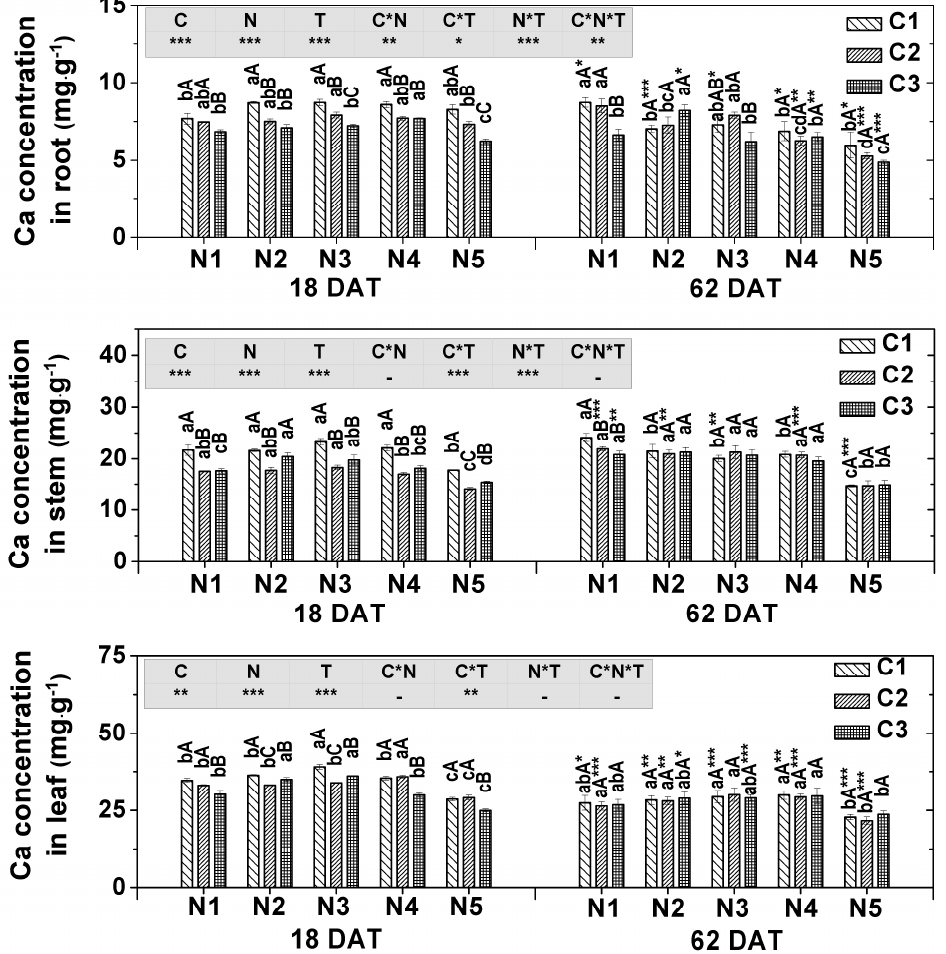
Figure 5. Calcium concentrations in different tissues of cucumber plants grown under different N and [CO 2 ] levels at two growth stages ( n = 6). Bars represent standard errors. CO 2 levels: C1, C2, and C3: 400, 625, and 1200 μ mol mol − 1 . N levels: N1, N2, N3, N4, and N5: 2, 4, 7, 14, and 21 mmol L − 1 . Means not followed by the same lower case letters are significantly different among different N levels in the same CO 2 level and growth stage, and not followed by the same upper case letters are significantly different among different CO 2 levels in the same N level and growth stage, according to Duncan’s test at p < 0.05. Means with asterisks are significantly different between two growth stages in the same CO 2 and N level (* p < 0.05; ** p < 0.01; *** p < 0.001). In the internal table, C: [CO 2 ] level; N: N level; T: growth stage. Asterisks (*) indicate significant differences (* p < 0.05; ** p < 0.01; *** p < 0.001); - indicates non-significant differences ( p ≥ 0.05).